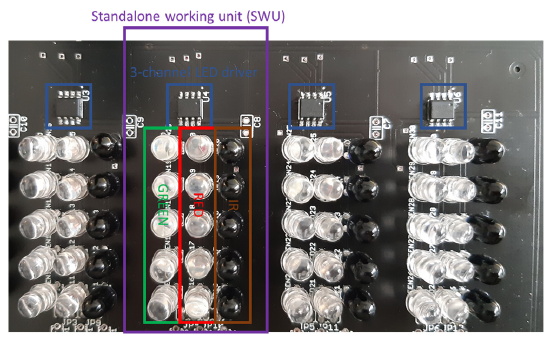
Figure 4. Standalone working unit of the illumination device. Table 1. Selected technical parameters of used LED diodes [26–28].